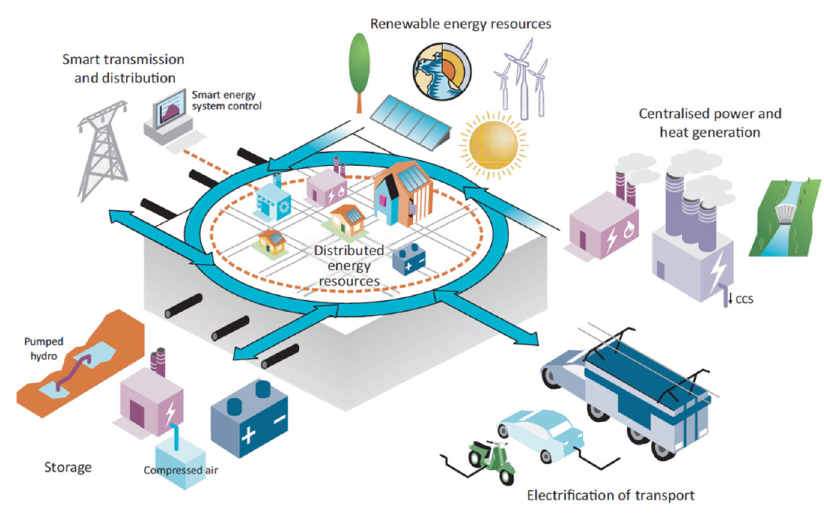
Figure 4. The integrated and intelligent electricity system of the future [24] In the new scheme of power generation, the local power supply is called a microgrid (MG) which bind together to organize the local balance of the power system. If a microgrid cannot achieve the balance, then it will get power from the neighbor microgrid or the strong backup system to assure constant frequency [25]. Figure 4 shows a “smart grid”, a combination of local networks with active consumers and small storage, a strong backbone network, and powerful generators. The buildings, as one of the main consumers of electricity in today’s platform, will play an active role in the system, where they become flexible storage or even a supplier for the grid [26]. 2.2. Option for Future Decentralized Microgrid Energy Structures Microgrids are a group of interconnected loads and distributed energy resources within defined electrical boundaries, which act as a single controllable entity with respect to the grid. It can be connected and disconnected from the grid since it is capable of operating in both grid-connected and islanded modes [14]. Microgrids have been researched for decades [27], however, increasing penetration of distributed energy resources (DERs) into the existing power sector is raising the motive to develop advanced technologies for MG power generation units [28]. Besides the global warming effects, the increasing penetration of DER is attributed to fossil fuel shortage and political instability in the major energy-supplying countries [14]. Moreover, production costs for developing distributed energy resources declined due to technological improvements, hence the renewable energy sector has witnessed a boom in the past decade [14]. In the decentralized scheme, low power loss in the transportation of electricity due to the proximity of the production unit to the consumer is another attractive feature promoting it. Advanced MG systems will improve energy security and provide power that is efficient, reliable, and clean [18,29]. The international energy policies toward less GHG emissions are other key drivers for promoting renewable energy targets and DER, changing the MG role from a secondary energy source to a primary energy supply [27]. The rapidly increasing trend of microgrid integration into the electricity grid presents technical barriers and problems such as voltage stability, distribution system operation, control, and protection [30]. Technical challenges have been investigated for over a decade, and now can offer a stable and smoother energy supply [14]. However, the operation and maintenance of MG power units show improvement prospects for more reliable power generation.